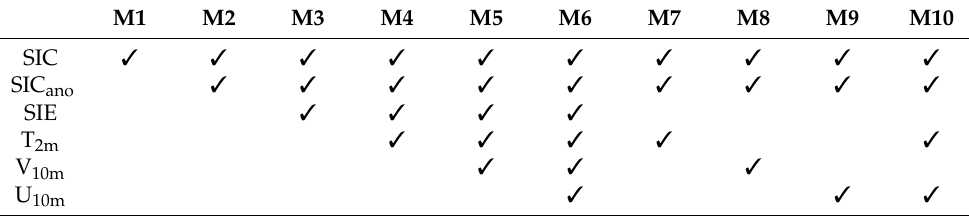
Table 2. A comparison of the sensitivity of the prediction models with varying combinations of input